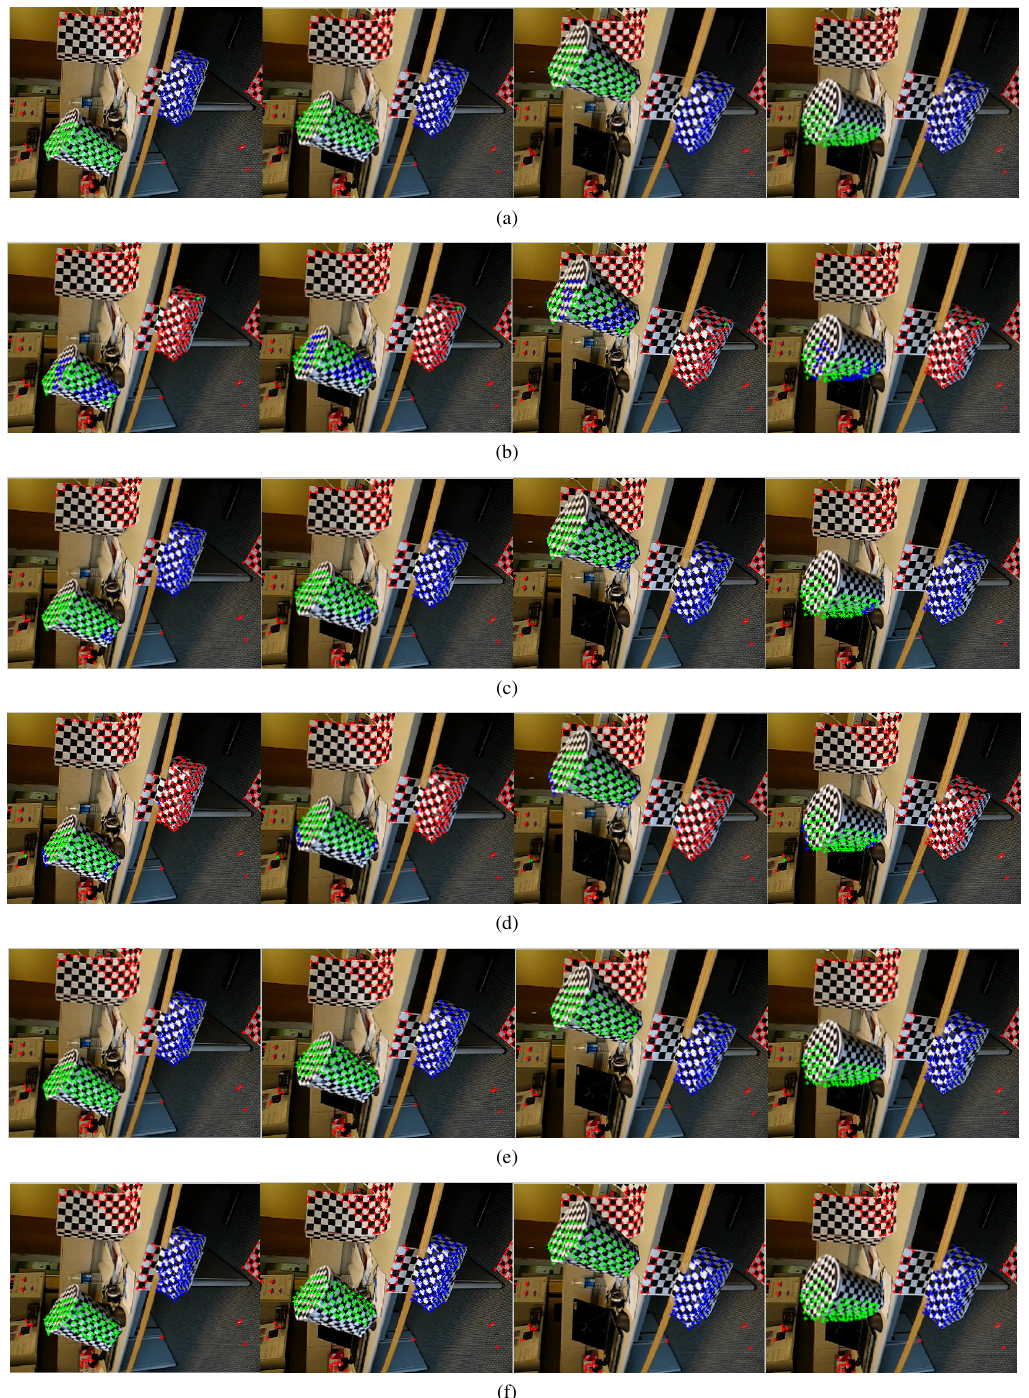
Figure 5: Comparison of Our approach with ground truth and the other approaches on the 1RT2RC video: 5(a): GroudTruth; 5(b): GPCA, error: 44 . 98% ; 5(c): LSA, error: 1 . 94% ; 5(d): RANSAC, error: 33 . 66% ; 5(e): SSC, 0% ; 5(f): Our, 0% on the 1RT2TC sequence from the Hopkins 155